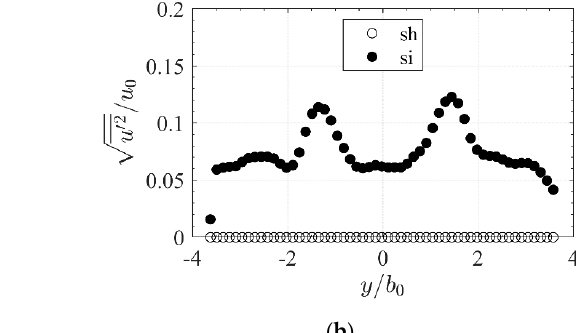
Figure 5. Lateral distributions of ( a ) mean normalized streamwise velocity 𝑢(cid:3364)/𝑢 (cid:2868) and ( b ) turbulence intensity (cid:3493)𝑢 (cid:4593)(cid:2870) (cid:3364)(cid:3364)(cid:3364)(cid:3364)/𝑢 (cid:2868) in the inlet section of the homogeneous slot configuration (inlet sh 𝑥 = −3 ) at 𝑧 = 0.5 ℎ (cid:2868) where 𝑢 (cid:2868) = 𝑄/𝑏 (cid:2868) ℎ (cid:2868) for configura- tions sh-des , si-des. Distances 𝑦 are normalized with channel/slot width 𝑏 (cid:2868) .